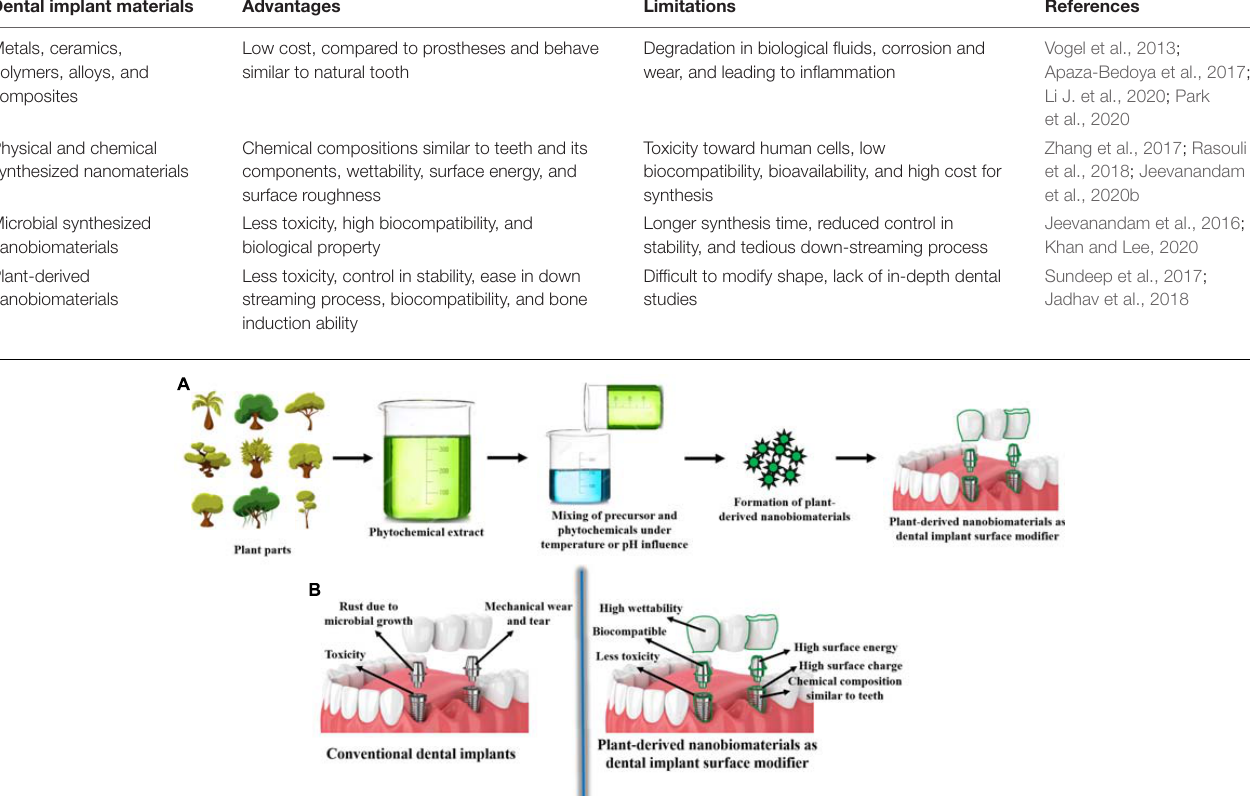
FIGURE 1 | (A) Schematics of nanobiomaterials synthesized from plants for dental implant applications; (B) Schematics showing the limitations of conventional dental implants and advantages of plant-derived nanobiomaterials as surface modifiers of dental implants.